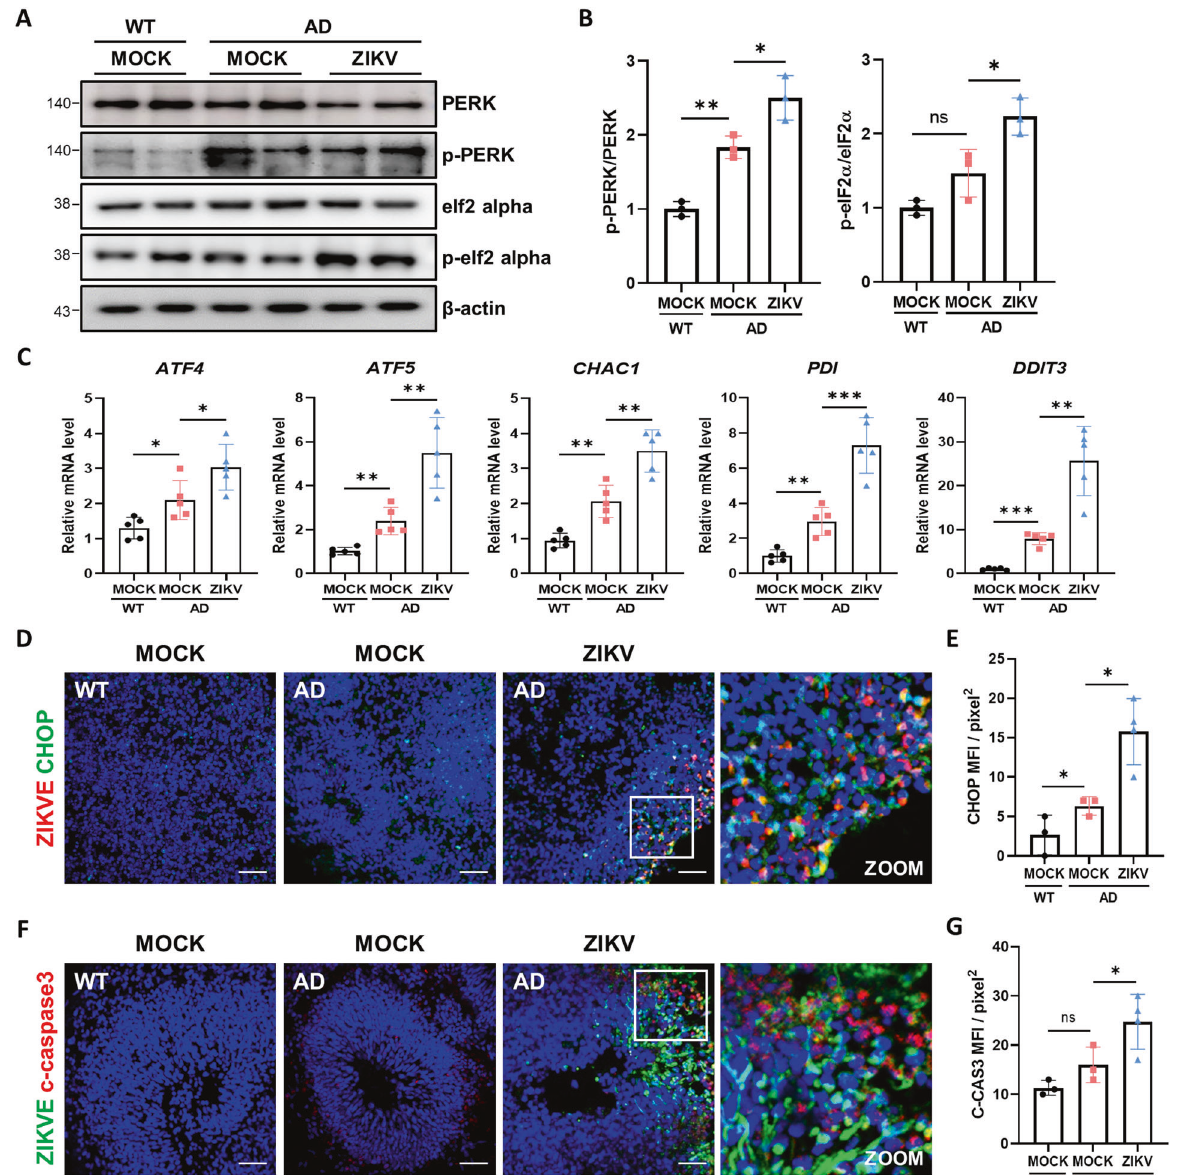
Fig. 5 PERK-eIF2 α activation is associated with AD phenotypes in ZIKV-infected organoids. A Western blotting of PERK, p-PERK, eIf2 α , p-eIf2 α , and β -actin in WT and AD organoids exposed to Mock conditions and ZIKV. B Quanti fi cation of p-PERK and p-eIf2 α . p-PERK was normalized to total PERK and p-eIf2 α was normalized to total eIf2 α ( n = 3). C RT-qPCR analysis of ATF4, ATF5, CHAC1, PDI , and DDIT3 levels in total RNA extracts obtained from ZIKV-infected AD brain organoids and mock-treated samples on day 75 ( n = 5). D Immunostaining of WT and AD organoids exposed to mock and ZIKV showing ZIKVE and CHOP (ER stress marker). White square shows ZIKV-infected area. Scale bars, 50 µm. E Quanti fi cation of CHOP-positive cells 14 dpi ( n = 3). F Immunostaining of WT and AD organoids exposed to mock and ZIKV showing ZIKVE and cleaved caspase3 (apoptosis marker). White square shows ZIKV-infected area. Scale bars, 50 µm. G Quanti fi cation of cleaved caspase3-positive cells 14 dpi ( n = 3). n.s.: not signi fi cant, * P < 0.05, and ** P < 0.01. The data are presented as the mean ±